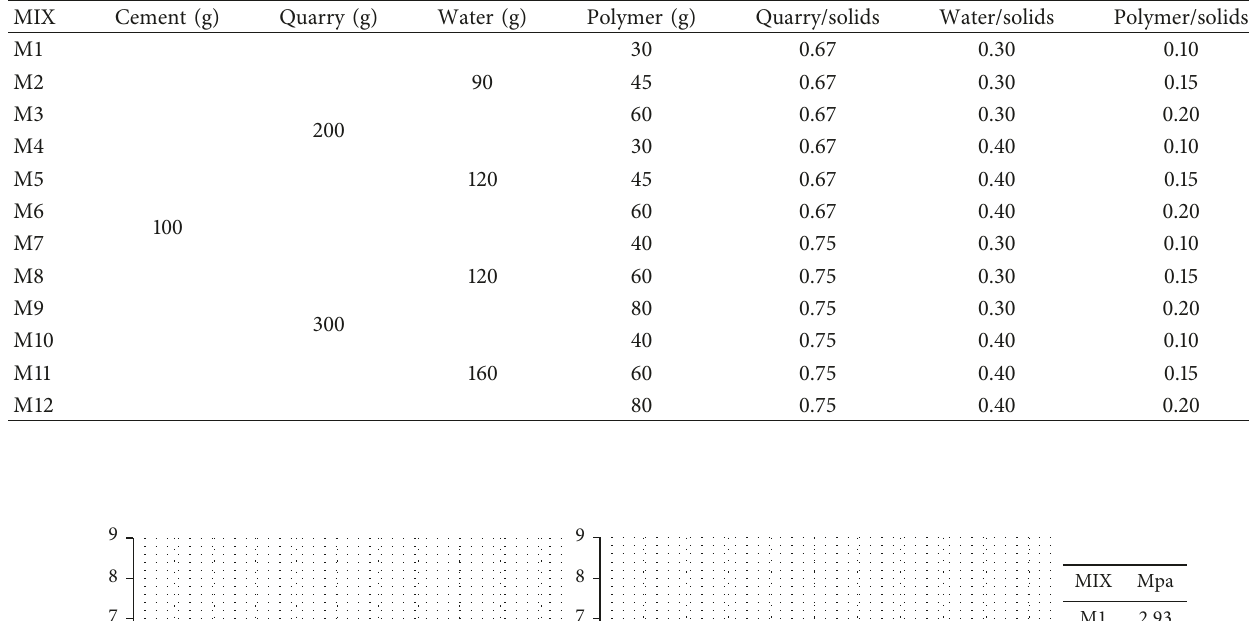
Table 3: Quantities in grams for the different concrete mixtures (own source).